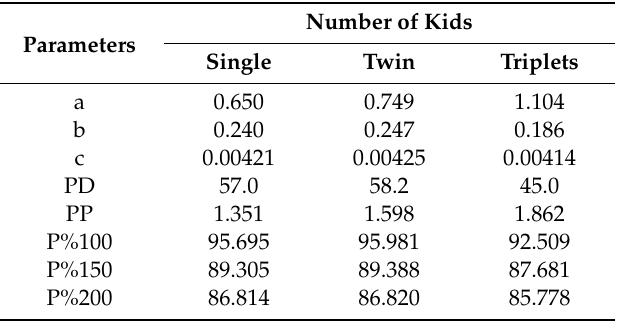
Table 6. Average values across the number of kids levels for the parameters of the lactation curve (a, b and c); peak day (PD); peak production (PP); persistence percentage at 100 (P%100), 150 (P%150) and 200 days